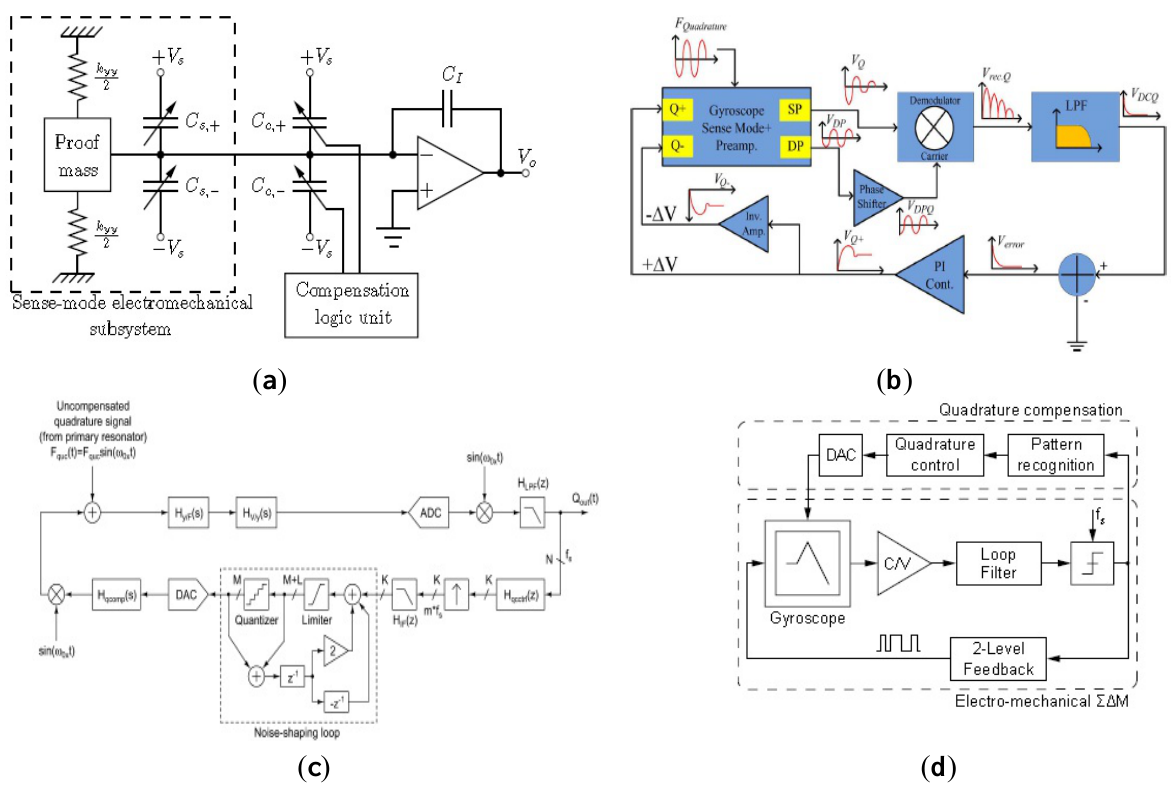
Figure 41. ( a ) Open loop charge-based compensation of the quadrature error. ( b ) Block diagram of the quadrature control electronics. ( c ) A feedback loop with ΣΔ DAC for quadrature signal compensation. ( d ) Electro-mechanical ΣΔ modulator with the proposed quadrature